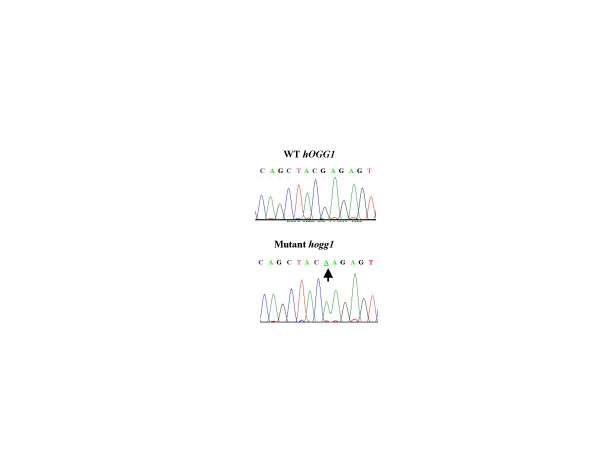
Sequence of hogg1 Mutant. hOGG1 (wild type) and mutant-hogg1 (mutant) were transfected in HeLa cells. 72 h post transfection, total RNA was isolated and RT-PCR was performed using Superscript II (Invitrogen, Carlsbad, CA) as per manufacturer's instructions. Automated DNA Sequencing results indicated that cells transfected with mutant-hogg1 harbored mutant hogg1, where CGA is changed to CAA at codon 229. Arrow indicates mutated position (G to A).